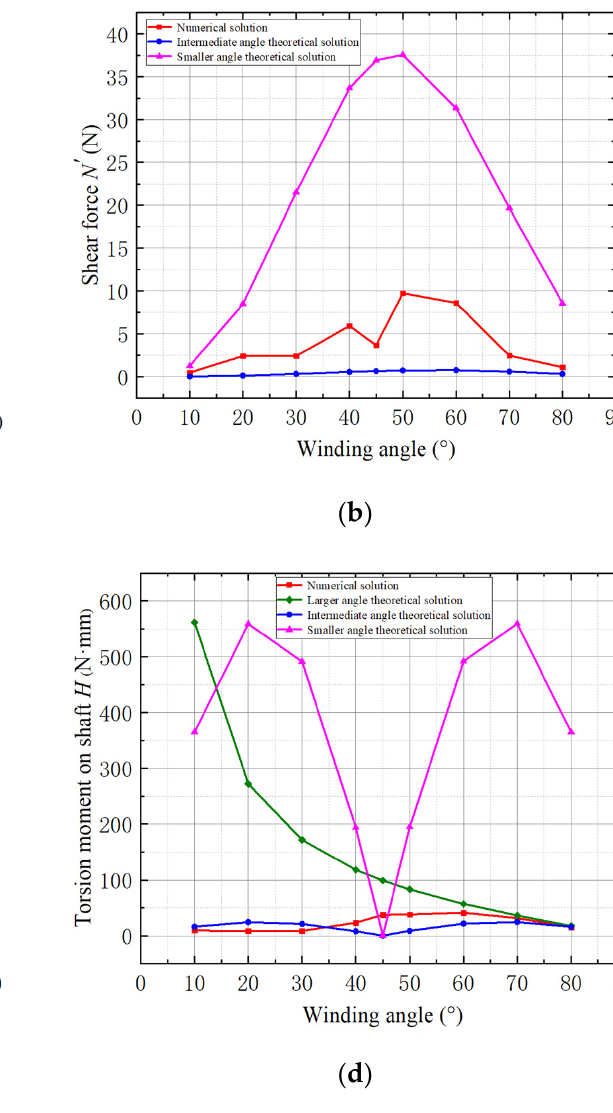
Figure 9. Internal force comparison point line diagram. ( a ) Axial tension, ( b ) shear force in the B-axis direction, ( c ) B-axis direction bending moment, ( d ) torsion moment on the shaft.